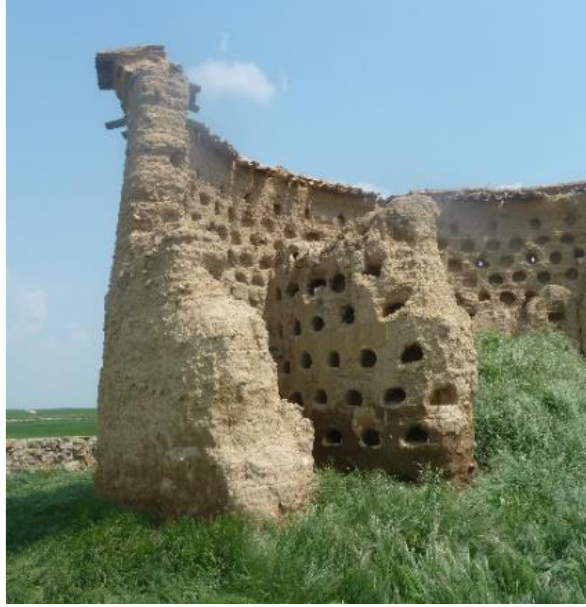
Figure 2. Abandonment by functional obsolescence of earthen architecture (dovecote in Castilla y León)